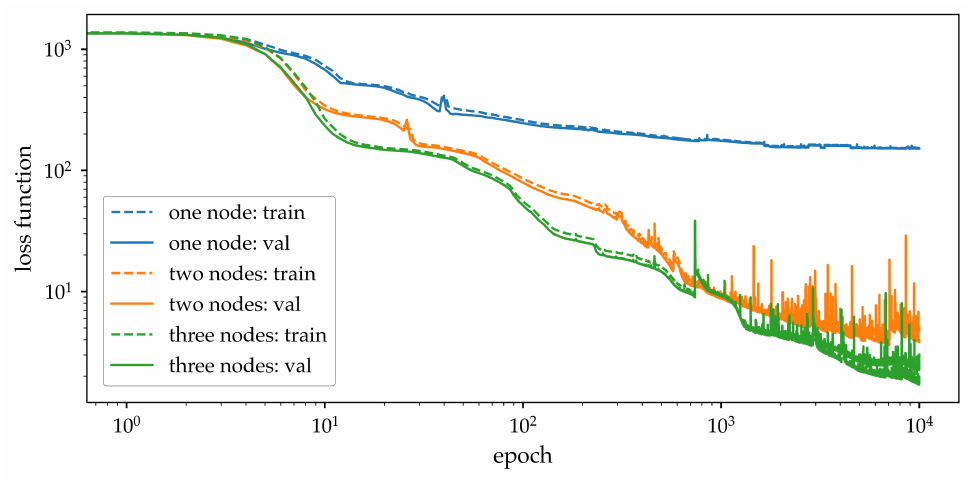
Figure 10. Loss as a function of epoch for the training and validation sets averaged over 10 trials. The training and validation sets are the same for all